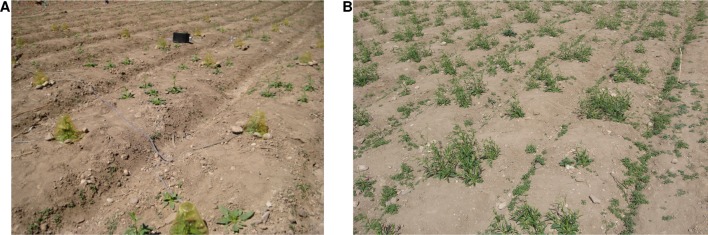
Photographs of the field experiment in season one.(A) Photograph of a closed-headspace volatile trapping showing ca. 25% of the experiment on May 7th of season one. (B) Photograph showing a similar portion of the experiment on May 23rd of season one.